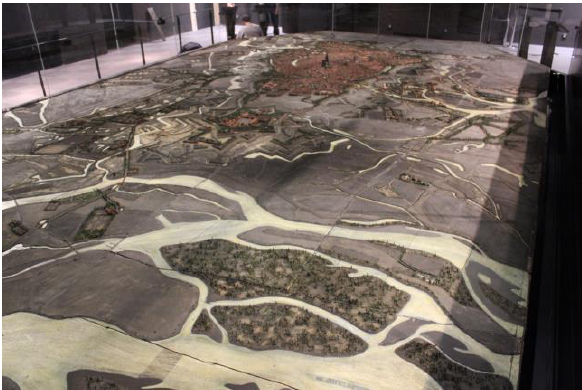
Figure 1. Scale model of Strasbourg of about 72